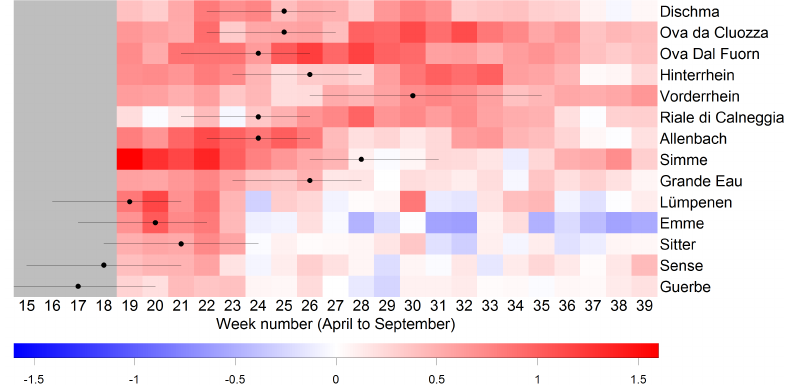
Figure 5. Dependence of 7-day minimum discharge on maximum SWE for all studied catchments (sorted by elevation from highest to lowest) for individual weeks from the beginning of May (week 19) to the end of September (week 39). April (weeks 15–18) was not included in calculation. Colour key provides Theil–Sen slope values. Red indicates positive effect of SWE on minimum discharge (positive slopes), blue indicates negative effect of SWE on minimum discharge (negative slopes). Black points indicate average week of melt-out, whiskers represent 10 and 90% quantiles.